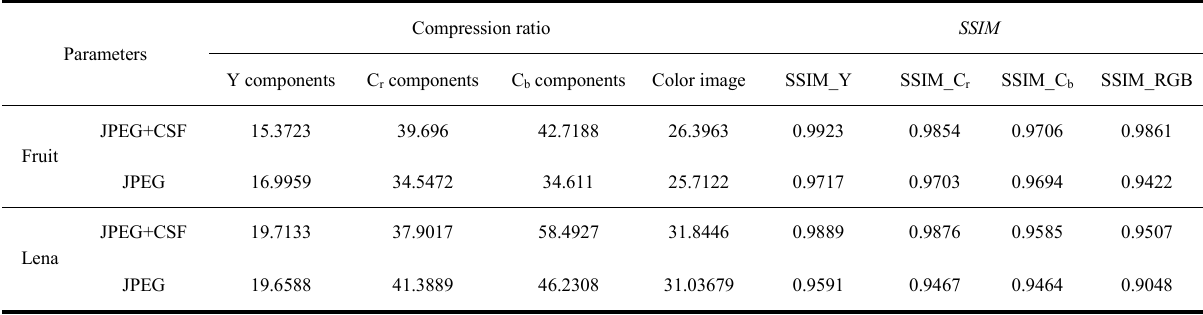
Fig. 6 Comparing the data of the quantized images with ones of the original images for “Fruit” and “Lena” images in the transformation domain: (a) the frequency spectrum coefficients of the Y component of the original “Fruit” image, (b) the quantized results of sub-blocks with the size of 8×8 pixels of “Fruit” image, (c) the quantized results of the frequency spectrum coefficients of the Y component of the “Fruit” image, (d) the quantized results of the frequency spectrum coefficients of the color “Fruit” image, and (e) – (h) corresponding to the results of (a) – (d) for “Lena” images, respectively. Table 2 Computed results of SSIM for two color images and each component image under the corresponding compression